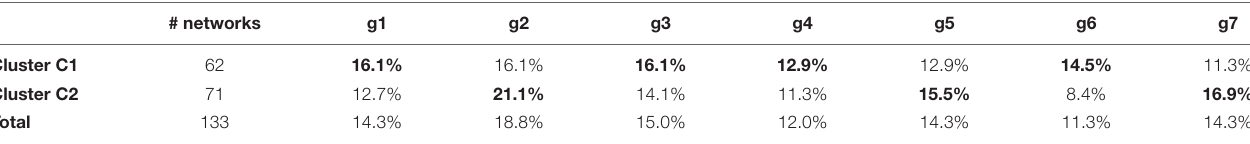
The bold values represent the larger percentage of subjects in the seven age groups for clusters C1 and